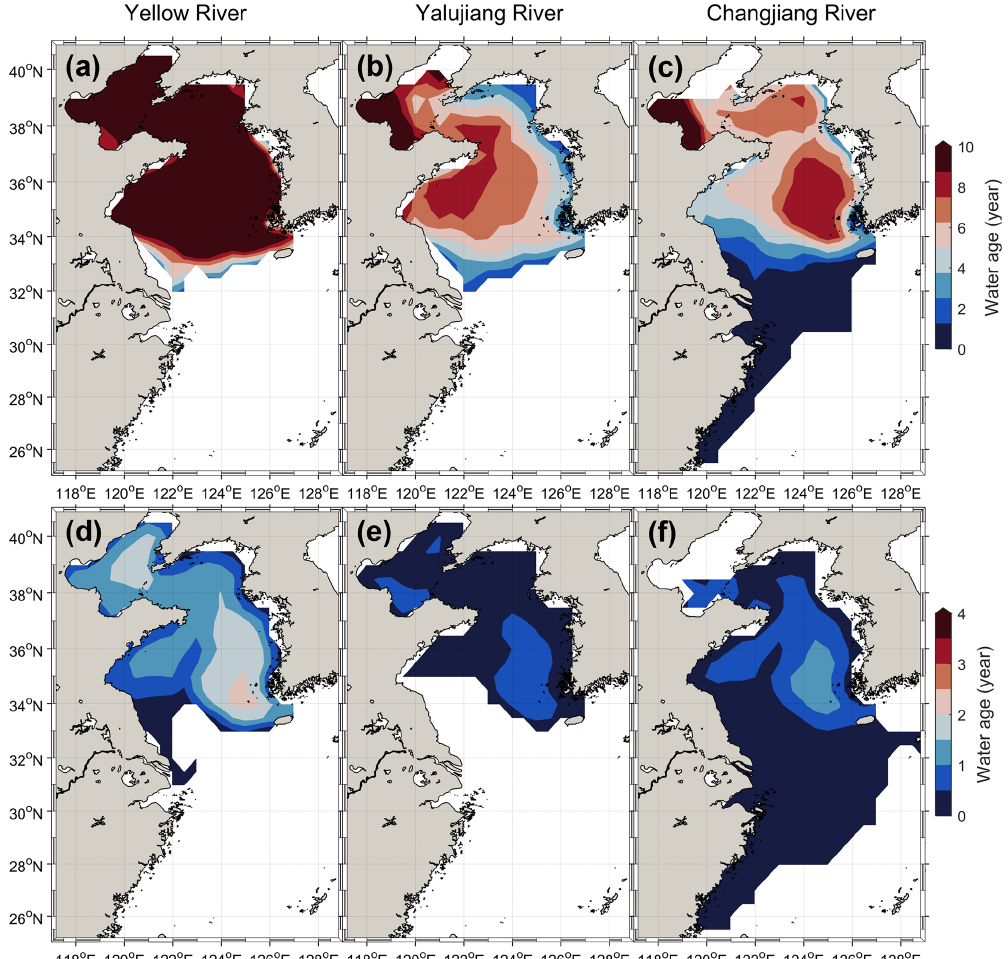
Figure 8. The annually and vertically averaged water age of the three rivers for the tidal–advection case (a–c) and tidal–mixing case (d–f) .